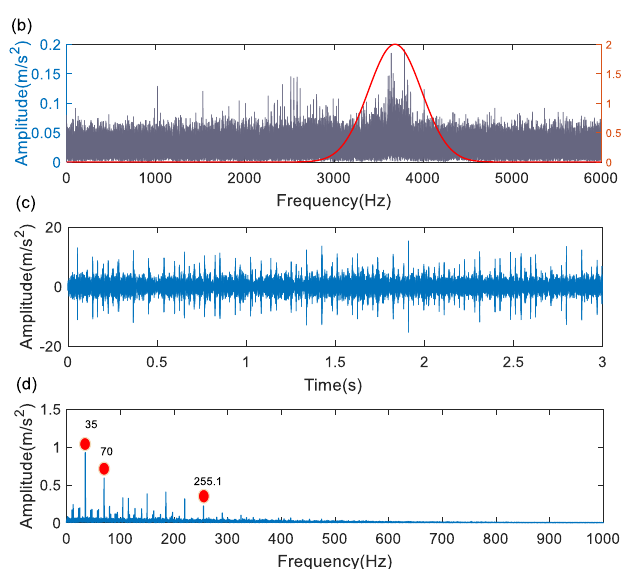
Figure 12. Results of Morlet wavelet for inner ring fault: ( a ) the parameter selection of the Morlet wavelet filter; ( b ) the spectrum and optimal filter; ( c ) filtered signal; ( d ) the envelope spectrum of the filtered signal.